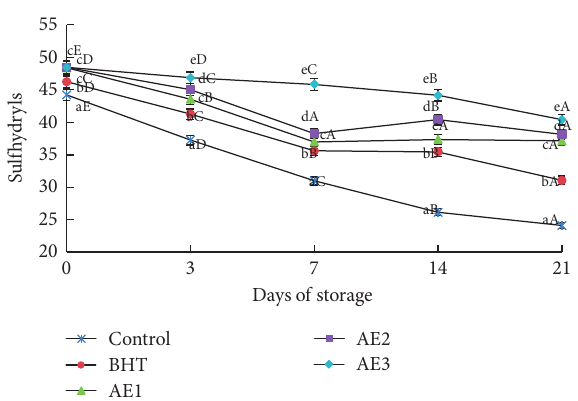
Figure 4: Effect of the aqueous pomegranate peel extract on sulfhydryl (nmoles sulfhydryl/mg protein) of minced beef meat during storage at 4 ° C. Figure 5: Effect of the aqueous pomegranate peel extract on peroxide values (meq peroxide/kg of meat) of minced beef meat during storage at 4 ° C.